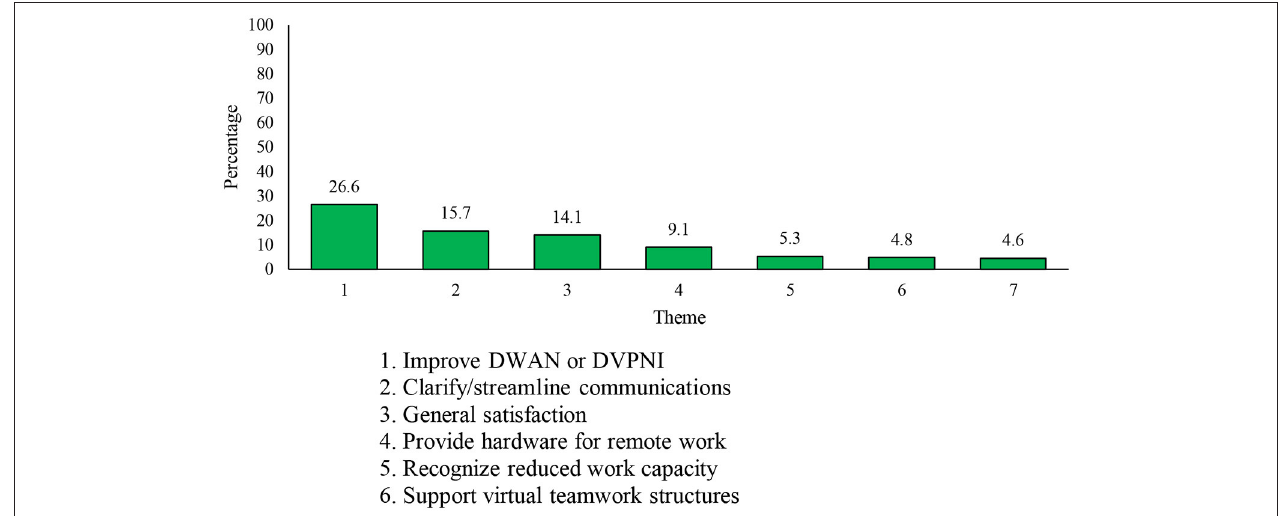
FIGURE 7 | Seven most frequently mentioned themes relating to how the DND/CAF can better support work during the COVID-19